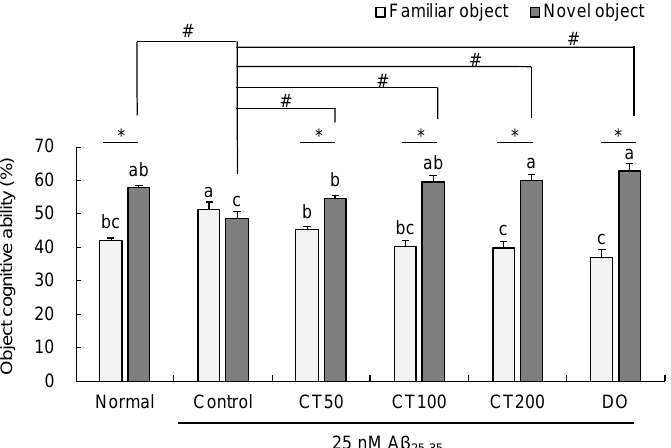
Figure 4. Effect of combination with Carthamus tinctorius L. seed and Taraxacum coreanum (CT) on novel object recognition test. Values are mean ± SD. a–c Means indicated with different letters are significantly different by Duncan’s multiple range test; * p < 0.05 vs. familiar object, # p < 0.05 vs. control group. Normal: 0.9% NaCl + water; Control: Aβ 25-35 + water; CT50: Aβ 25-35 + CT (50 mg/kg/day); CT100: Aβ 25-35 + CT (100 mg/kg/day); CT200: Aβ 25-35 + CT (200 mg/kg/day); DO: Aβ 25-35 + donepezil (5 mg/kg/day).